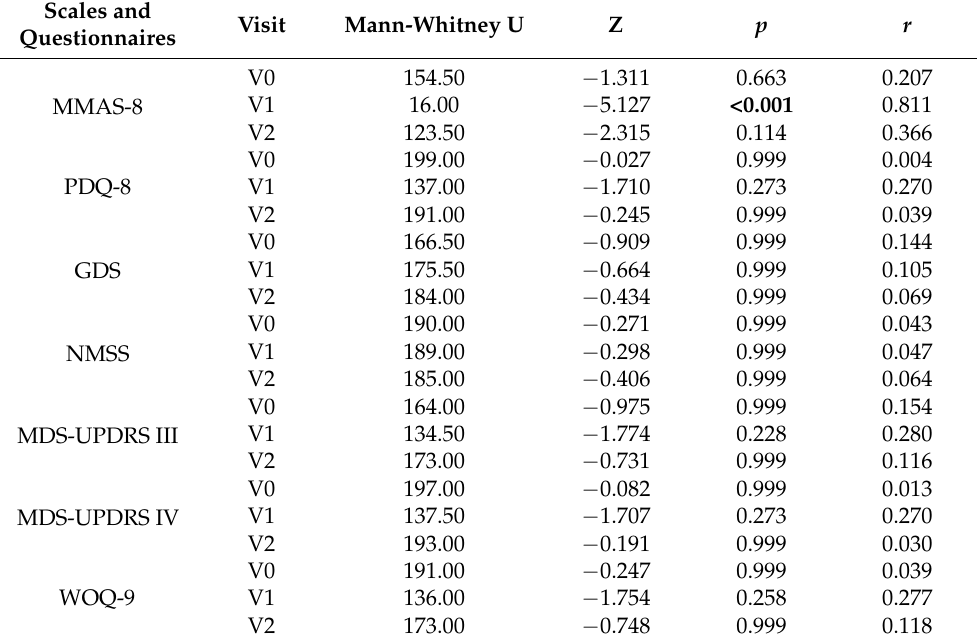
Table 3. Differences in the level of assessed variables between groups A (early-start intervention) and (A) and B (delayed-start intervention) (Mann–Whitney test). Timepoint V0 represents differ- ence between groups A and B in baseline. Timepoint V1 represents difference between active and control